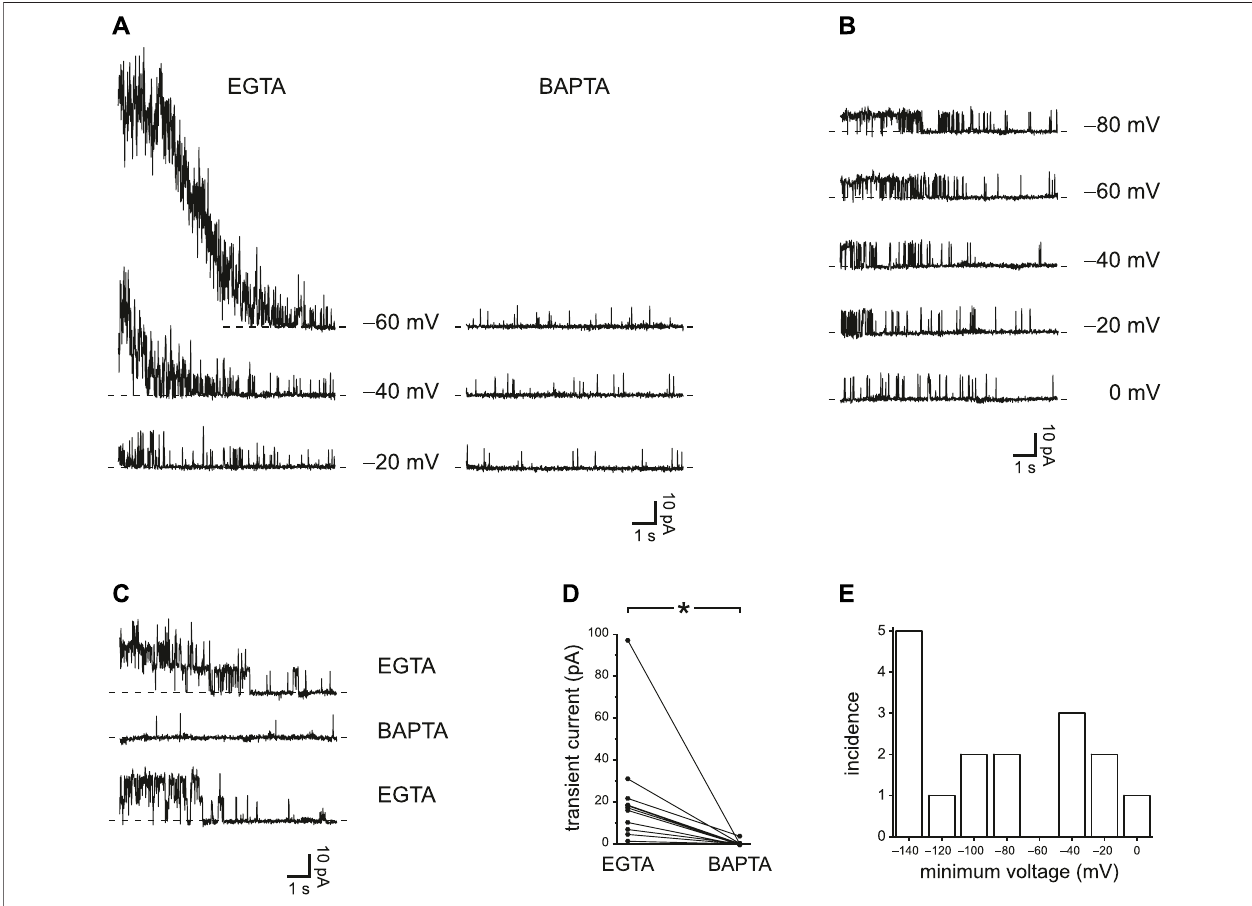
FIGURE 3 | Transient PC2 currents are greater with slower Ca 2+ buffering (0.25 mM EGTA compared to 0.25 mM BAPTA). (A) The recordings shown were made with 0.25 mM EGTA (left) or 0.25 mM BAPTA (right) at +20 mV immediately following prepulses of 10 s to the voltages shown. Postpulse currents are shown and were measured in the same cilium. This cilium had multiple active PC2 channels, preventing resolution of single-channel events. (B) In a cilium with just one PC2 channel, transient currents were also activated byprepulses of10 s to the voltages shown. The postpulse voltage was +40 mV and the buffer was 0.25 mM EGTA. (C) The effect of slower Ca 2+ buffering is reversible. A cilium showed transient currents in 0.25 mM EGTA before and after exposure to 0.25 mM BAPTA, in which transient currentswerenotseen.Prepulseandpostpulsevoltageswere − 80 mVand+60 mV,respectively. (D) Pairedtransientcurrentamplitudesfor11cilia,eachtestedinboth 0.25 mMEGTAand0.25 mMBAPTA.Voltageswerechosenthatgavethegreatesttransientcurrentin0.25 mMEGTA.Prepulsevoltagesrangedfrom − 140to − 60 mV and postpulse voltages from +20 to +80 mV. For a given cilium, the same pair of voltages was used in both EGTA and BAPTA. * p < 0.001. (E) Histogram showing the most positive prepulse voltage suf fi cient to cause a transient current in 0.25 mM EGTA in each of 16